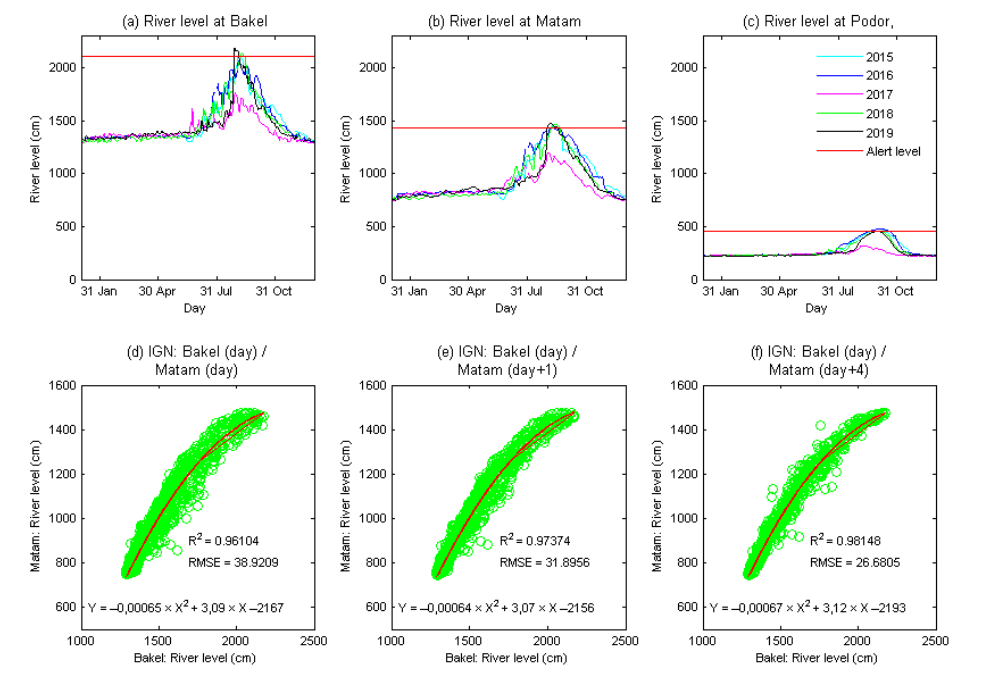
Figure 7. River levels (IGN) at the Bakel, Matam and Podor stations from 2015 to 2019 ( a – c ); river levels correlations for Bakel and Matam stations at the same day or with a time lag ( d – f ). Data source: Regional Hydraulic Division of Saint-Louis/Senegal.